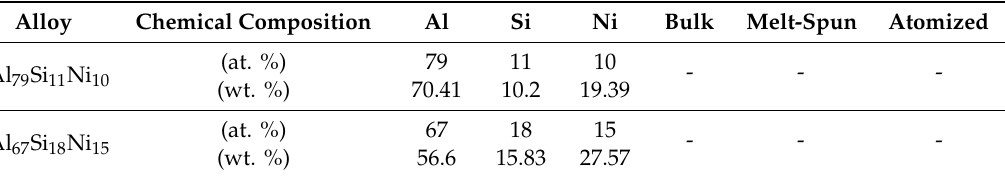
Table 1. Chemical composition of the Al–Si–Ni